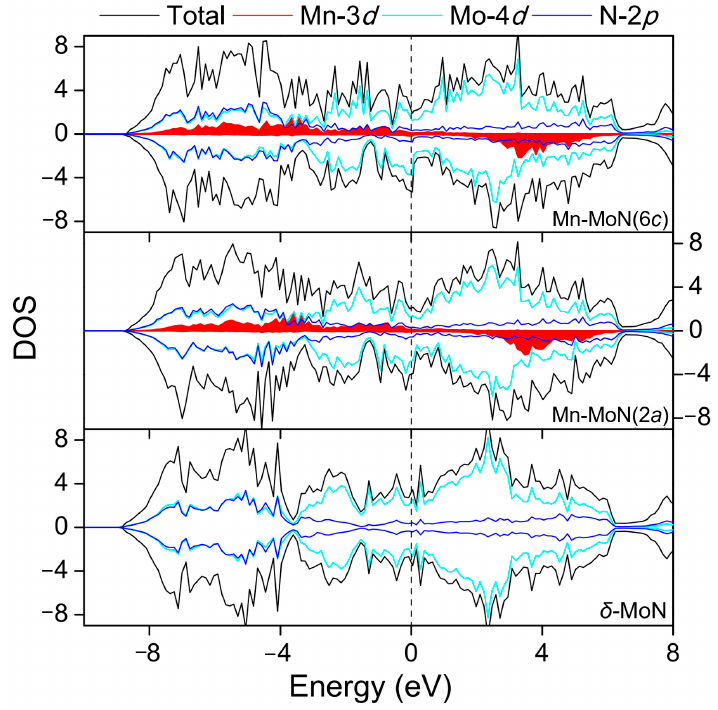
Figure 3. Total and partial DOS of δ -MoN, Mn-MoN(2 a ), and Mn-MoN(6 c ). The Fermi level is set as